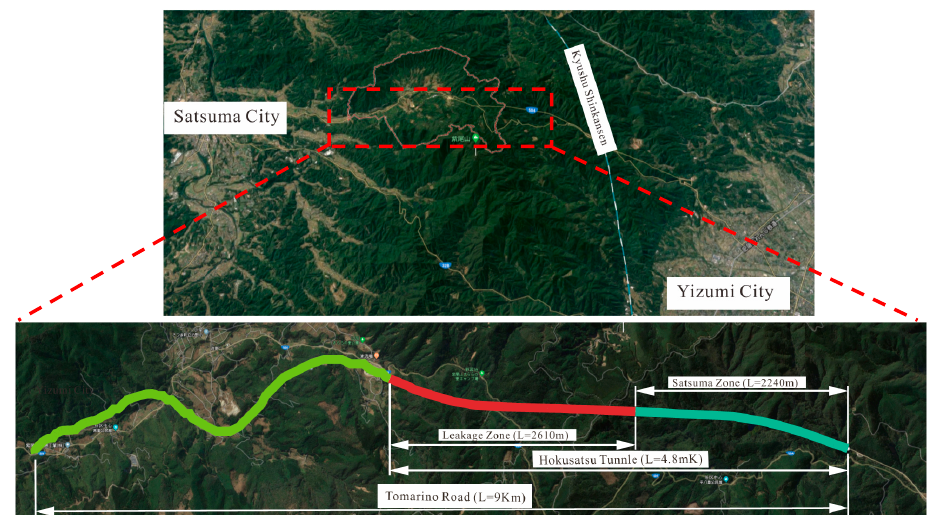
Figure 2. The location of leakage tunnel.